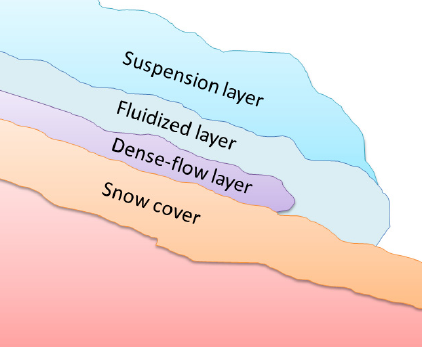
Fig. 1. Schematization of a multi-layer avalanche.